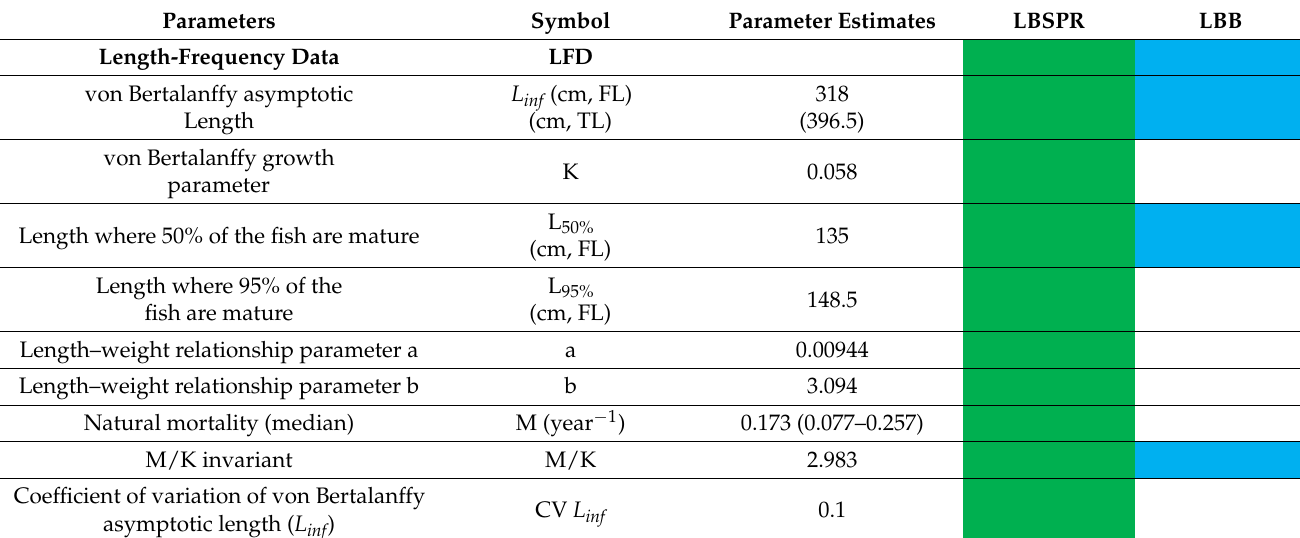
Table 1. Input parameter values used in this study for the Silky shark (two length-based mod- els